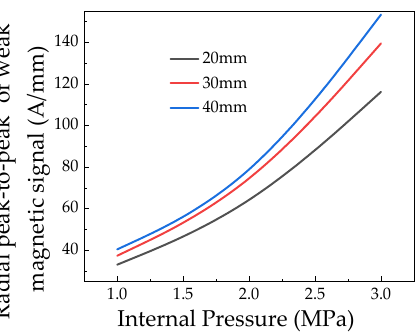
Figure12. Radialpeak-to-peakofweakmagneticsignalsofdi ff Figure 12. Radial peak-to-peak of weak magnetic signals of different crack lengths with internal pressure.